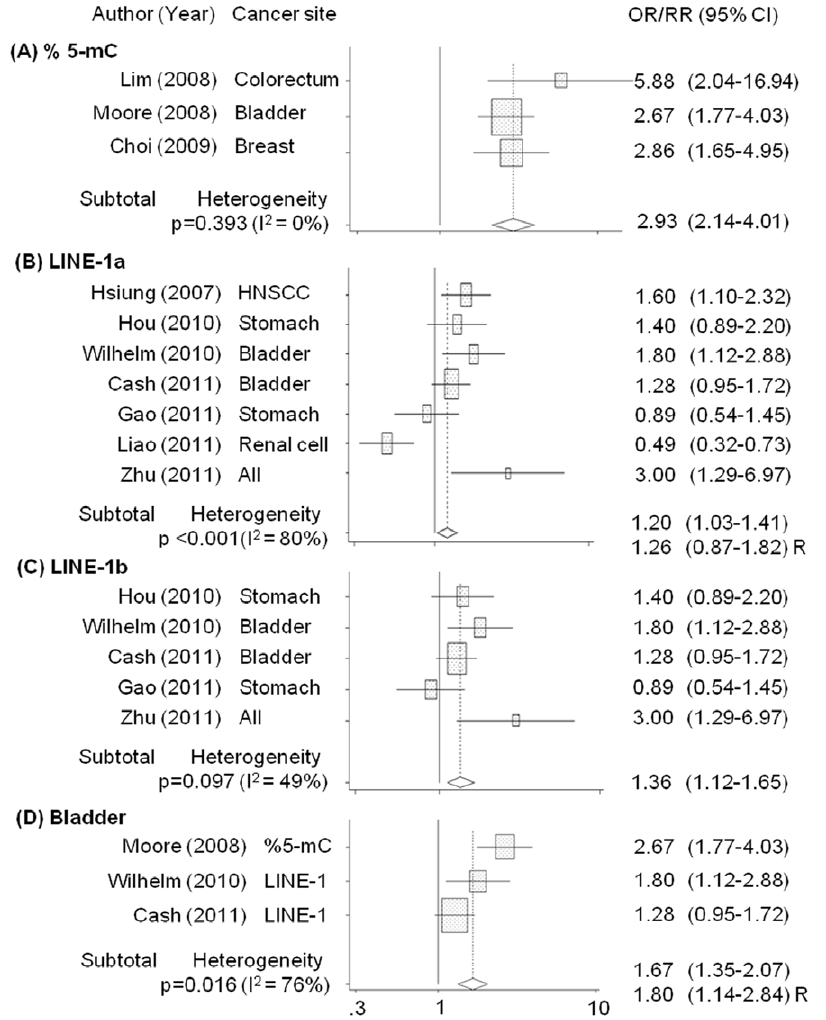
Figure 3. Subgroup analysis of the association between cancer risks and global DNA hypomethylation in peripheral blood leukocytes. (A) %5-mC, (B) LINE-1, and (C) LINE-1 used same target sequence. The association between bladder cancer risk and global DNA hypomethylation (D). R: random effects model. Summary estimates were calculated based on a fixed effects model, unless otherwise stated.